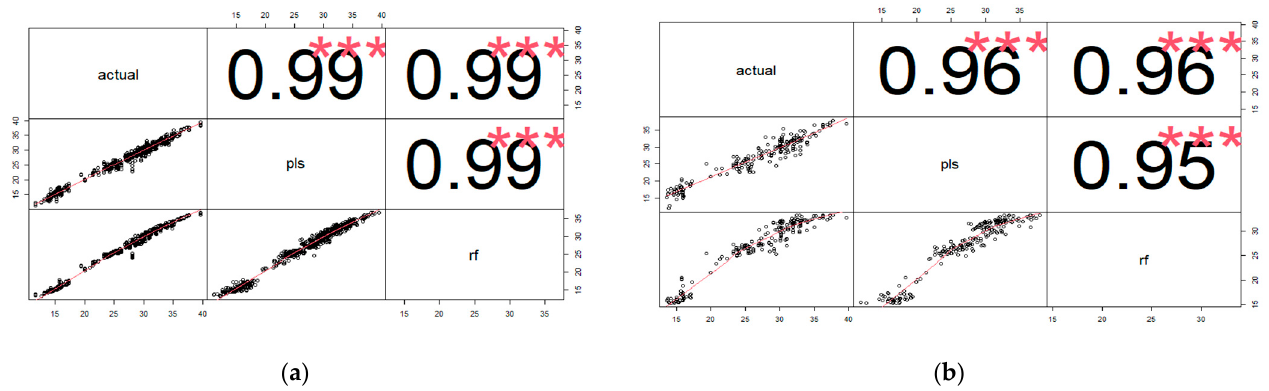
Figure 4. Correlation between actual and predicted Chroma Meter TCC values using PLS and RF calibration models in the training ( a ) and validation sets ( b ).